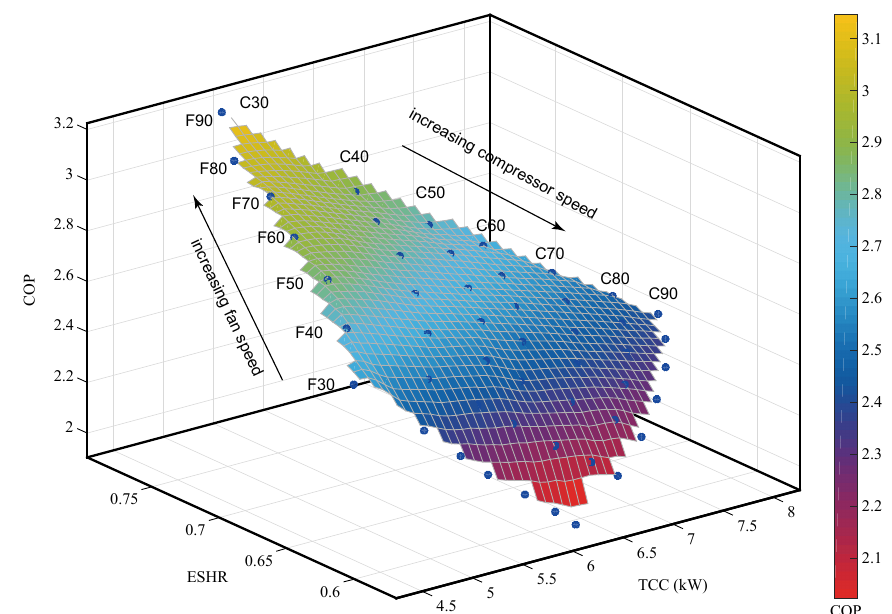
Figure 9. Improved inherent correlation among TCC E SHR and COP of the DX A/C system.